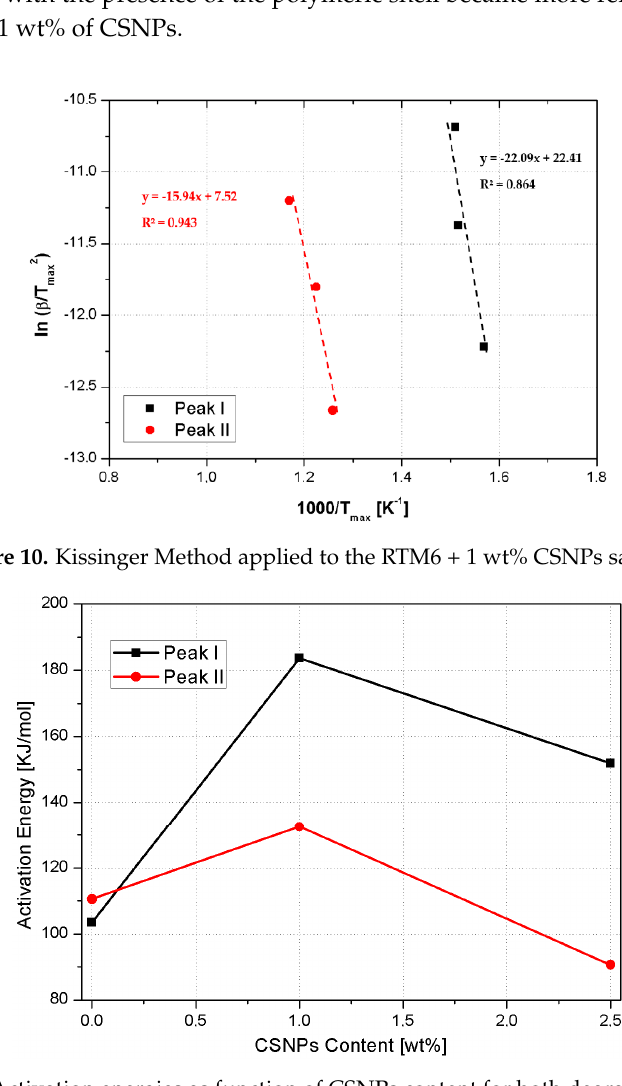
Figure 11. Activation energies as function of CSNPs content for both degradation steps. Table 3. Kissinger activation energies for each of the degradation steps for the CSNPs/RTM6 systems in